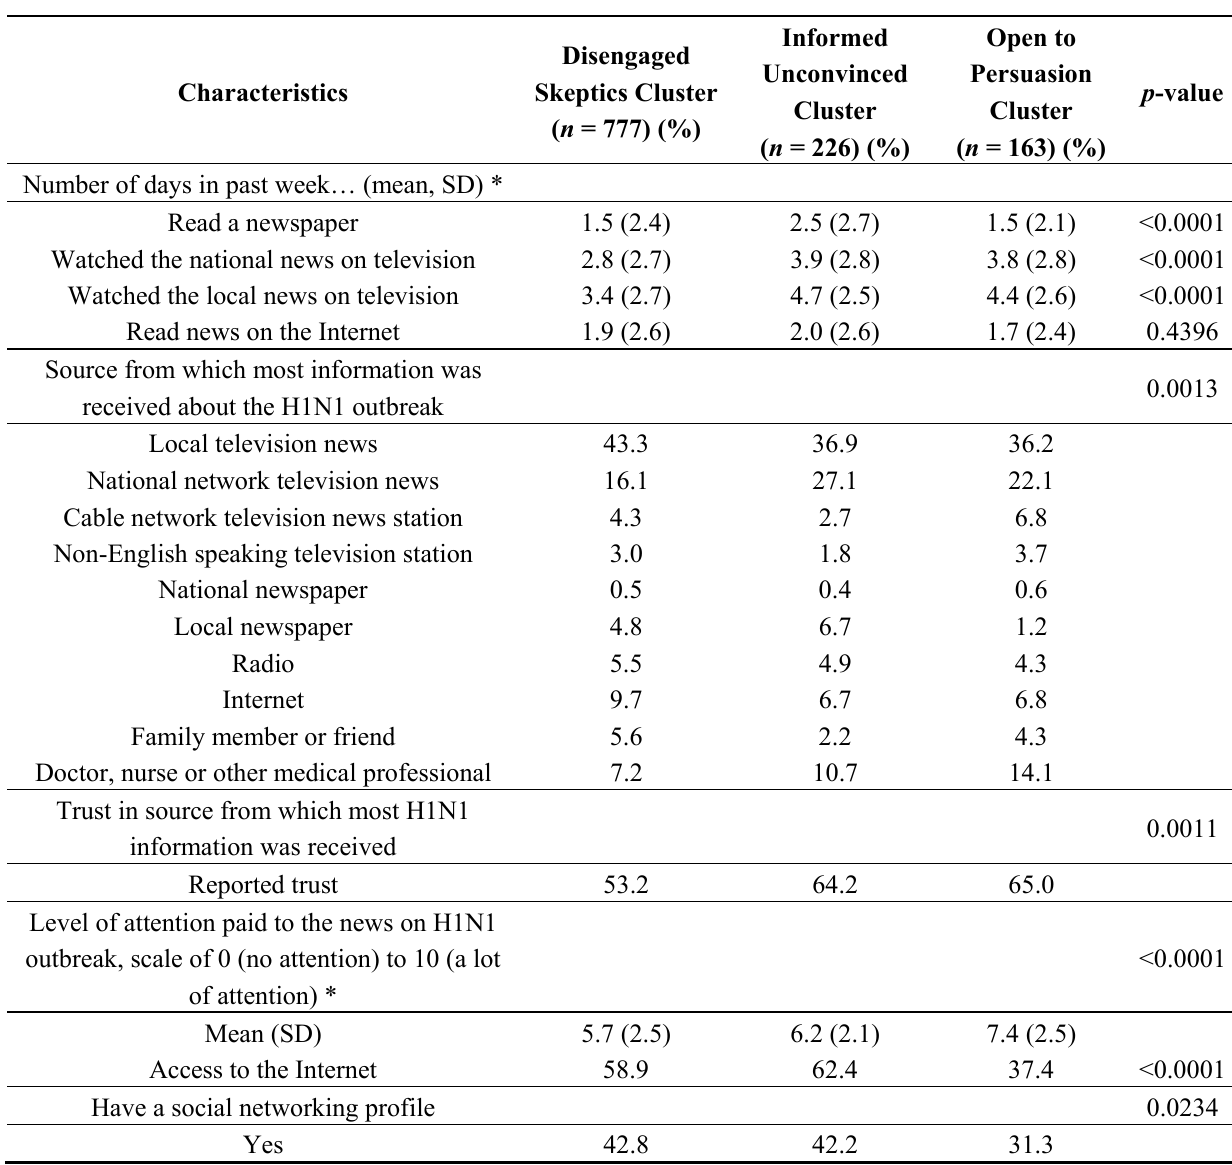
Table 4. Information access, use, and trust, by cluster ( n =